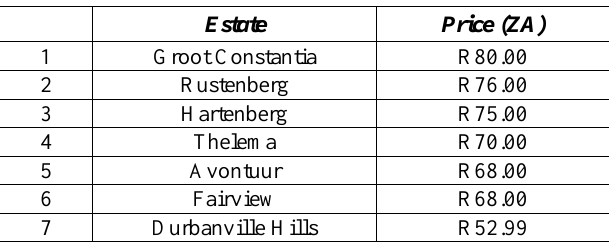
Table I: List of Sauvignon Blanc’s used in the